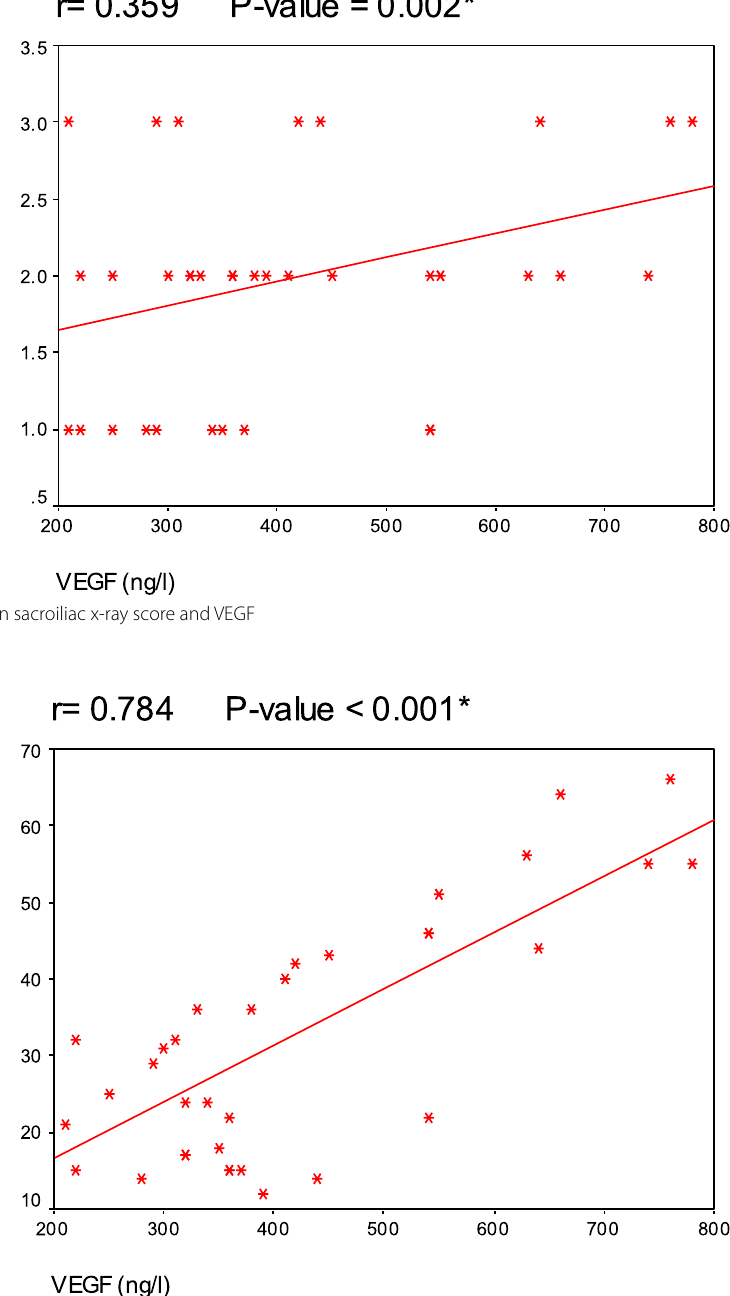
Fig. 5 Correlation between MSASS and VEGF